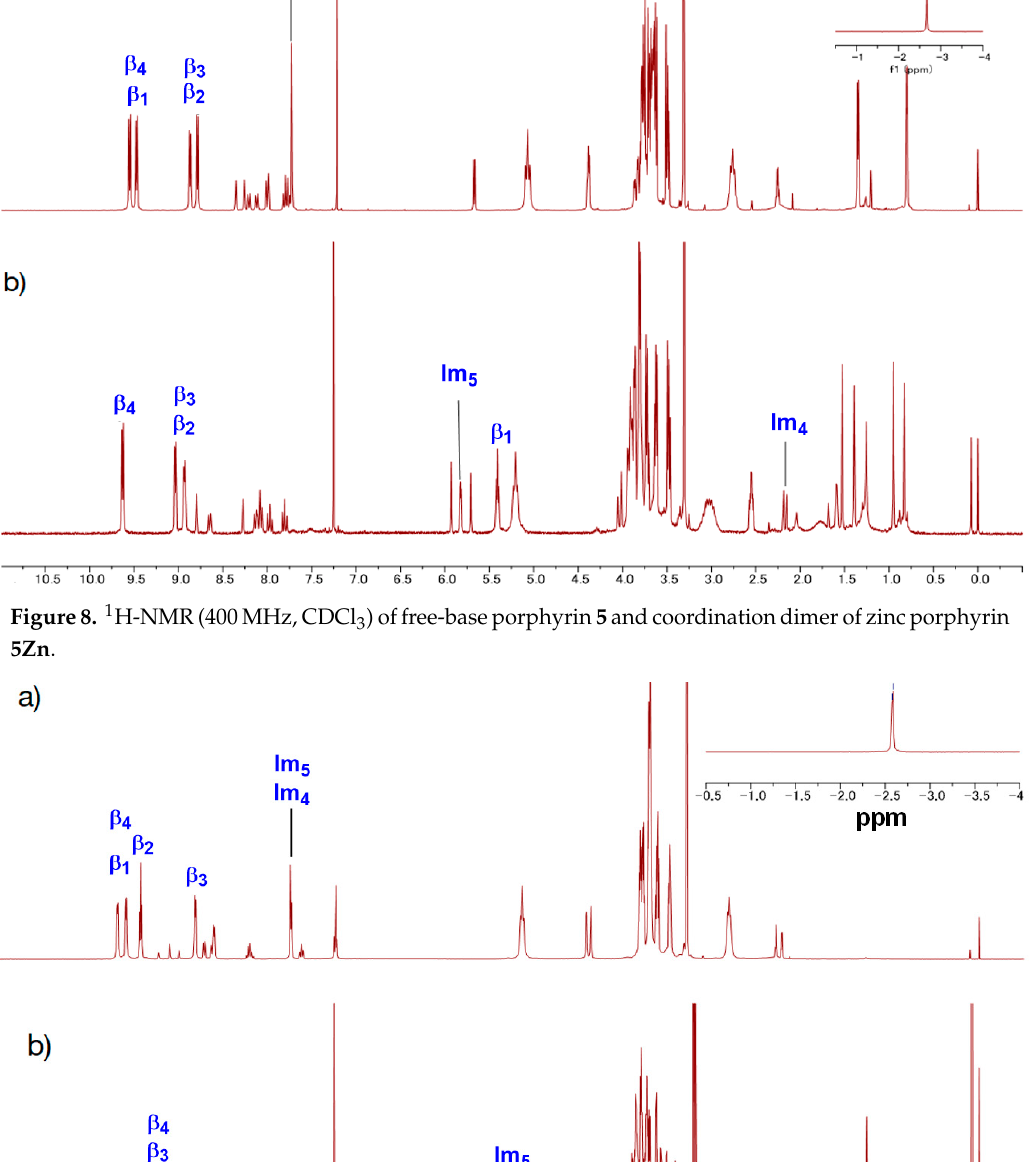
3 ) spectra of ( a ) GP1Fb and ( b ) GP1